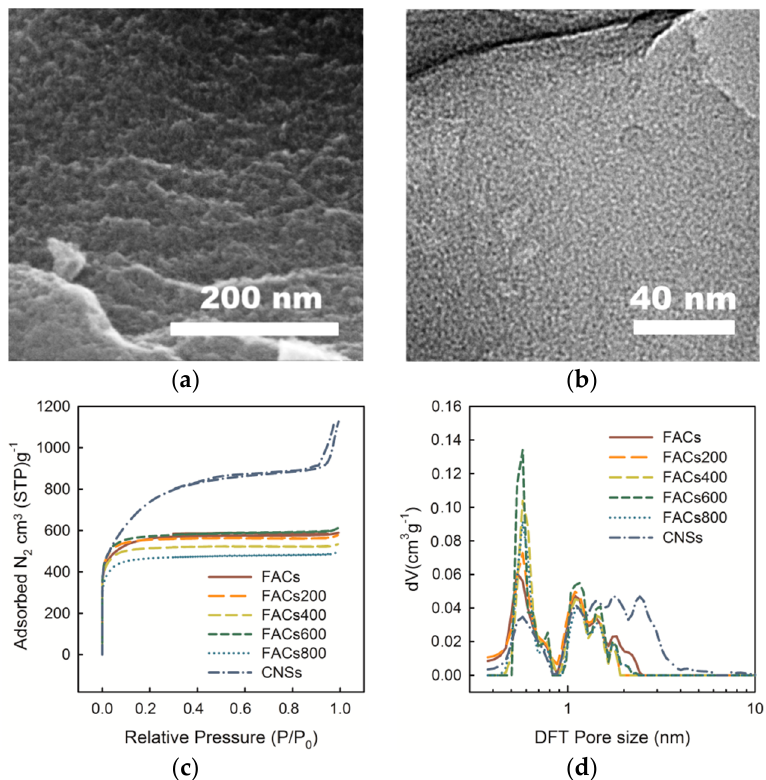
Figure 1. ( a ) SEM and TEM ( b ) images of the functionalized activated carbon cathode materials (FACs). ( c ) N 2 isotherms and ( d ) pore size distributions (PSDs) of FACs, FACs200, FACs400, FACs600, FACs800, and carbon nanosponges (CNSs) calculated by nonlocal density functional theory (NLDFT).